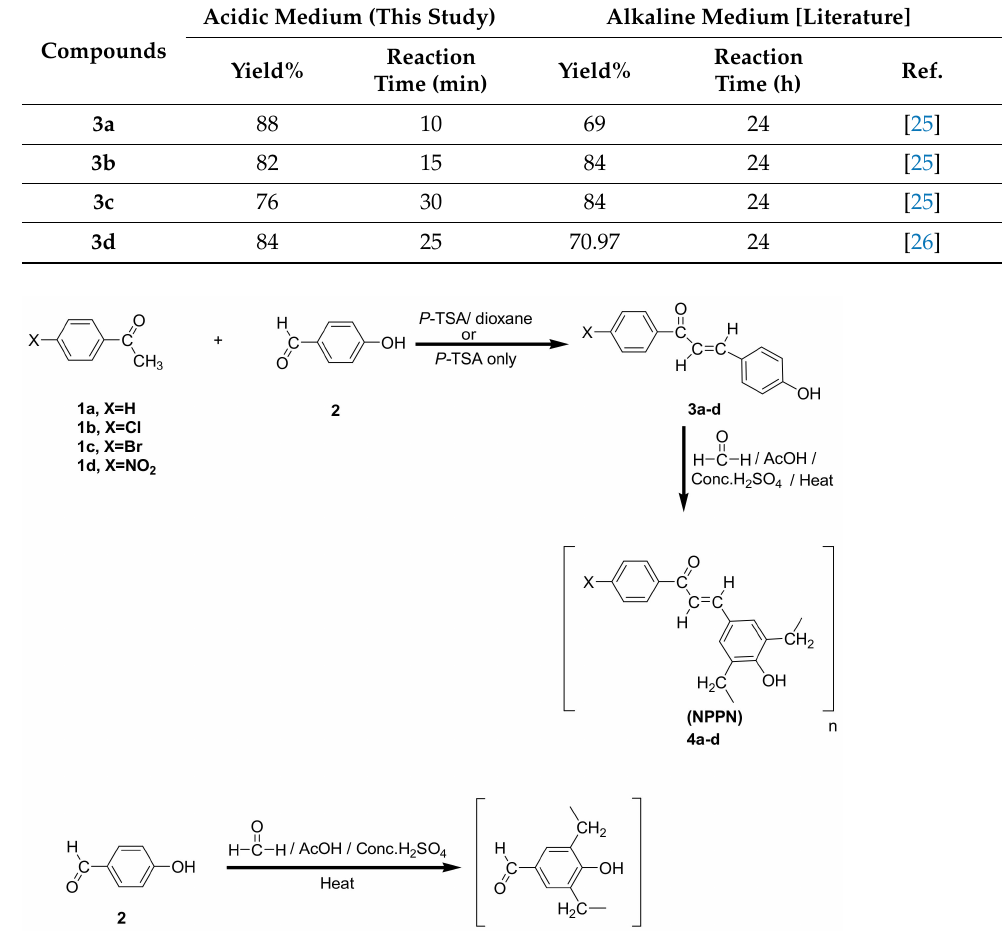
Table 3. Comparison between chalcones preparation in acidic and alkaline medium. Acidic Medium (This Study) Alkaline Medium [Literature] Compounds Reaction Reaction Yield% Yield% Time (min) Time (h)